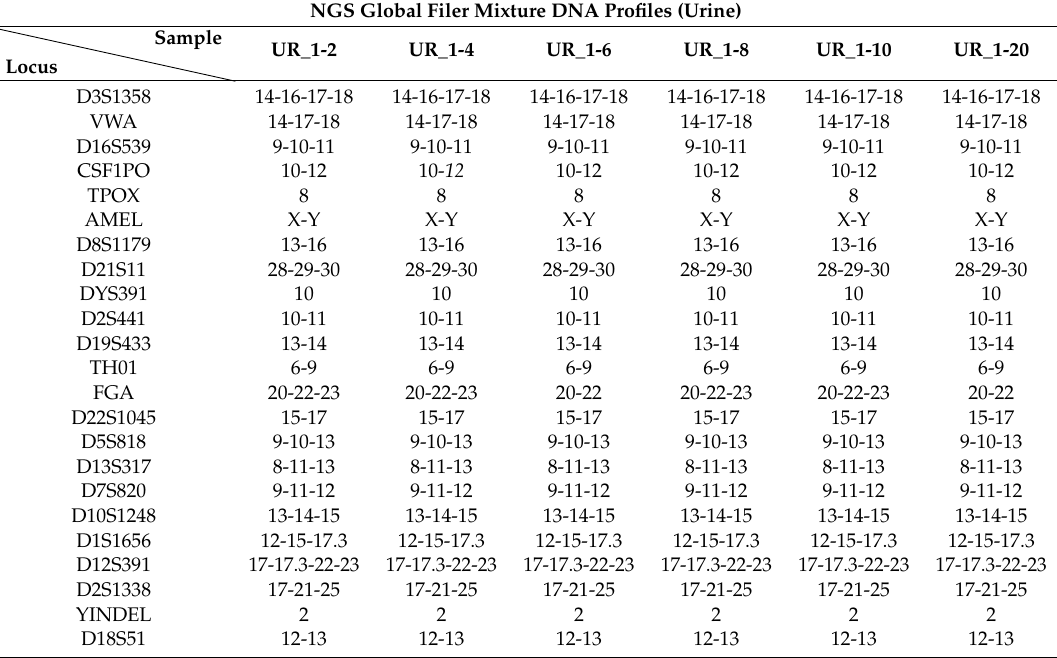
Table 5. Genotyping results for the urine-mixture samples. NGS: Next-Generation